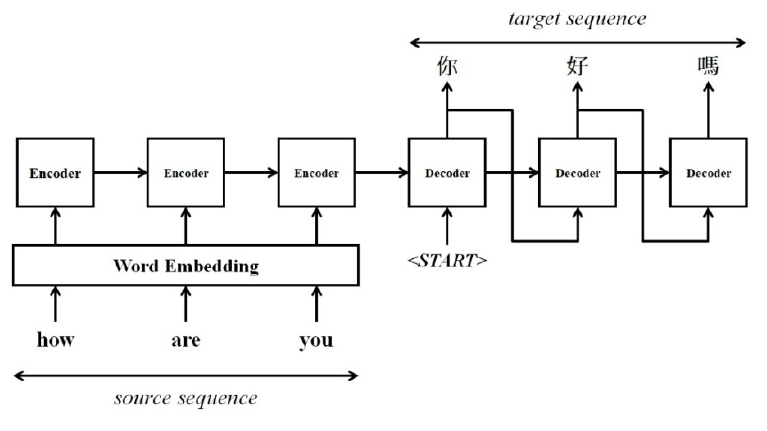
Figure 9. Seq2seq